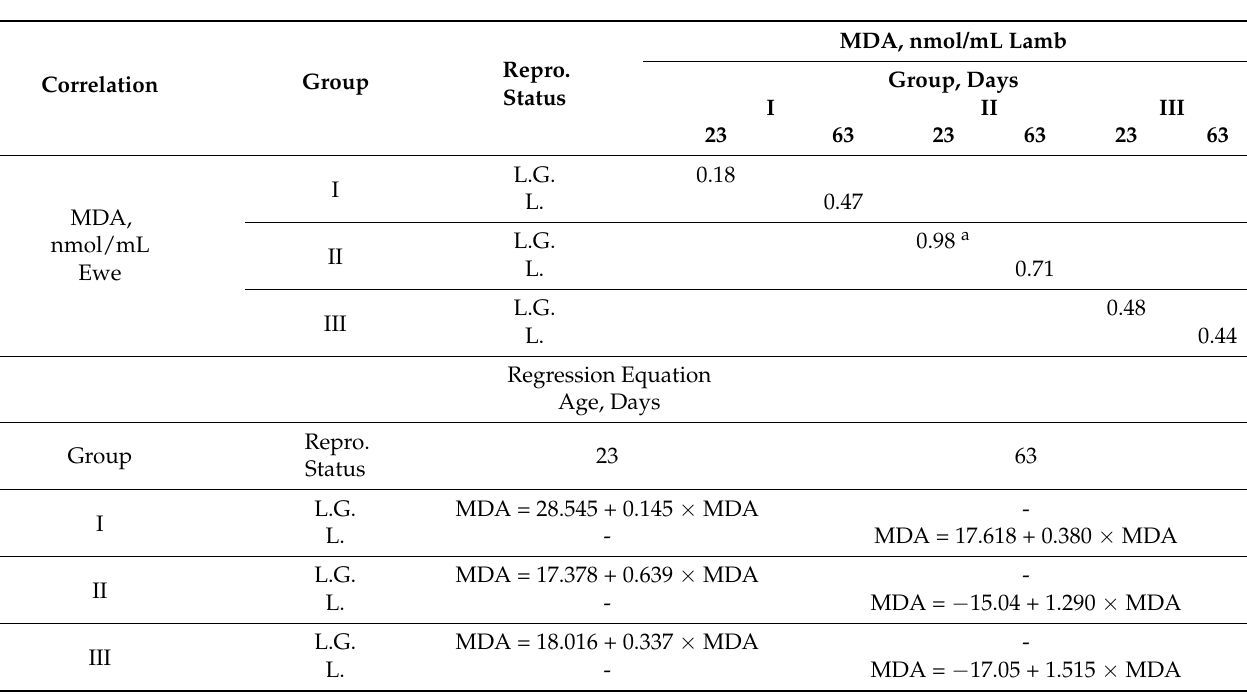
Table 8. Correlation coefficients and regression equations between the concentration of MDA in blood of ewes and